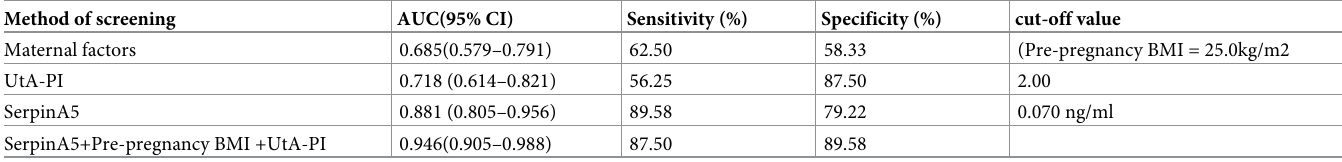
Table 3. Areas under the operating characteristic curve (AUC) and sensitivity (%) specificity (%) in screening by maternal factors and combinations with uterine artery pulsatility index (UtA-PI) and plasma SerpinA5 in pregnancy. Method of